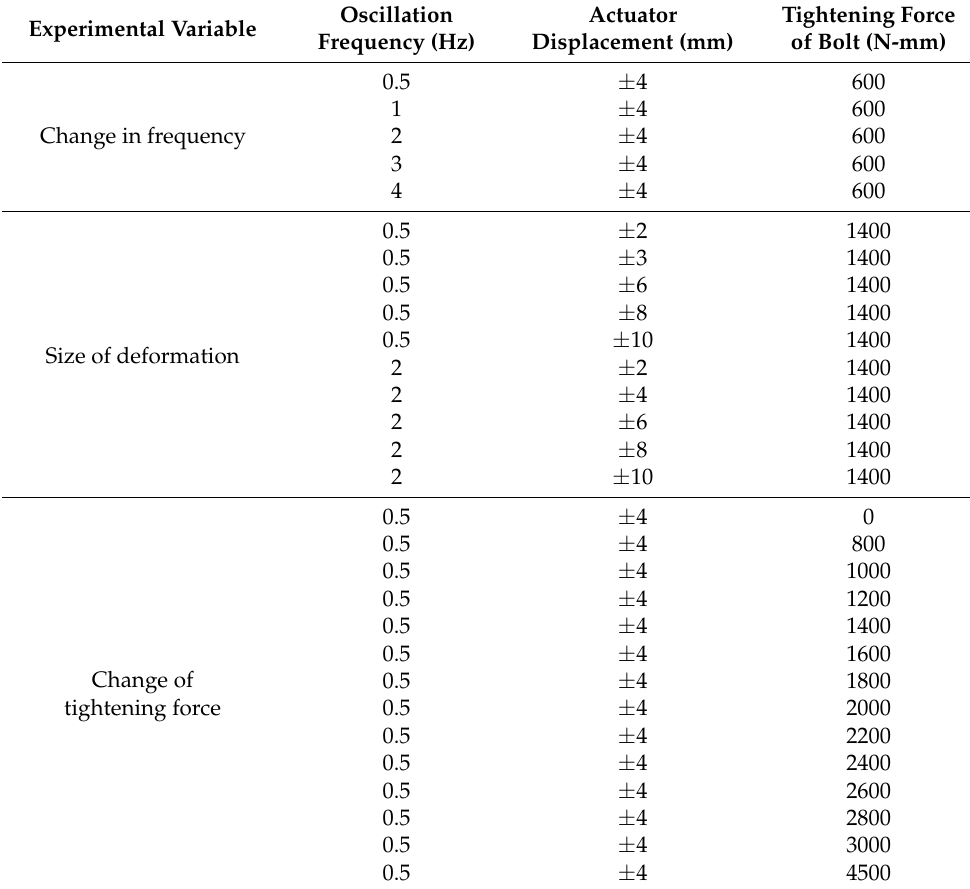
Table 3. Variables of rotary damper performance